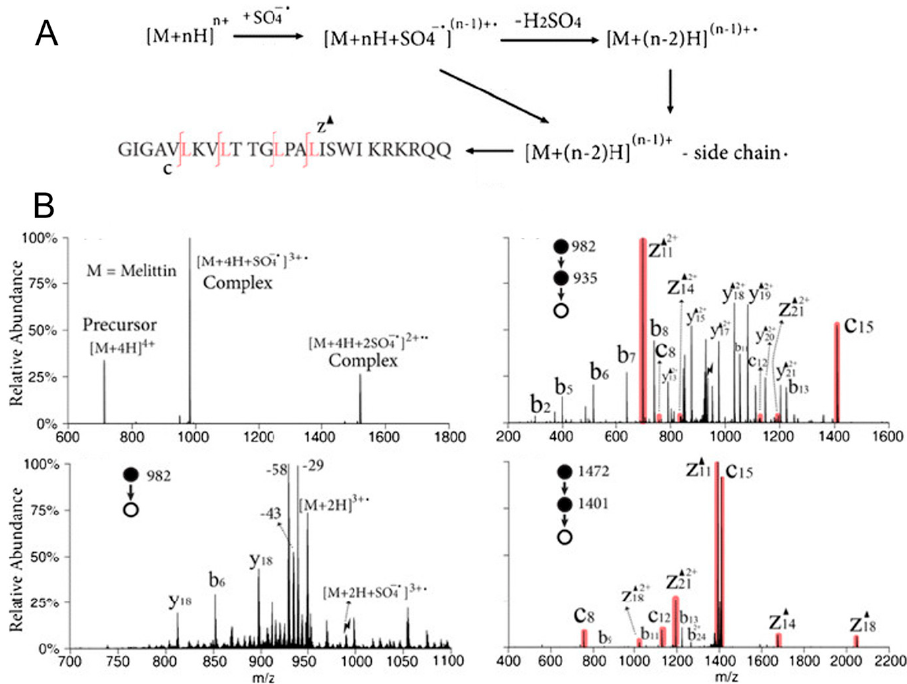
Figure 5. ( A ) Ion–ion reactions between sulfate radical anions and [M + 4H] 4+ of melittin and ( B ) multi-stage CID mass spectra for the structural elucidation of the peptide [111]. Adjusted and reprinted with permission from the American Chemical Society.